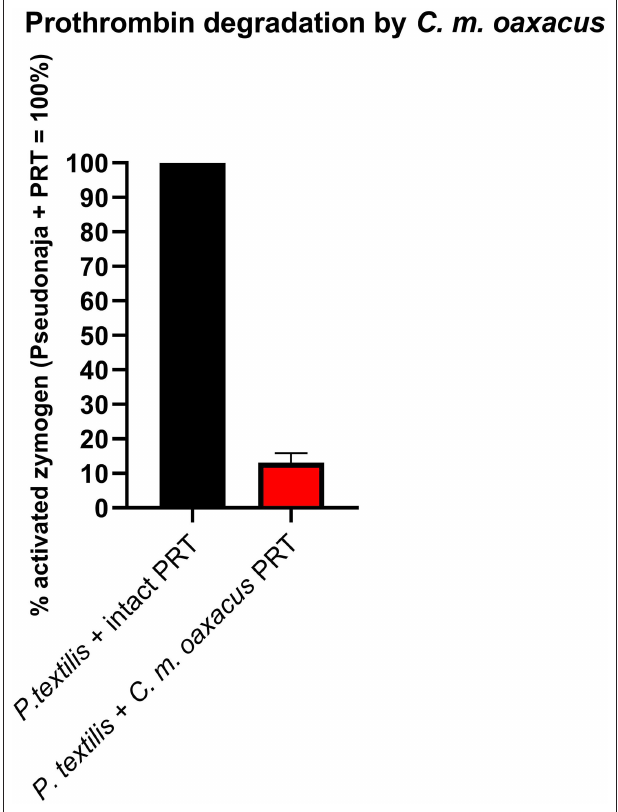
FIGURE 11 | Fluorometry graph showing degradation of prothrombin (PRT) by venom from C. m. oaxacus (Sierra de Cuatro Venados). Degradation is expressed as the difference in Pseudonaja -activated zymogen levels between intact zymogen (black) and zymogen previously incubated with C. m. oaxacus venom (red). Values are n = 3 mean ±